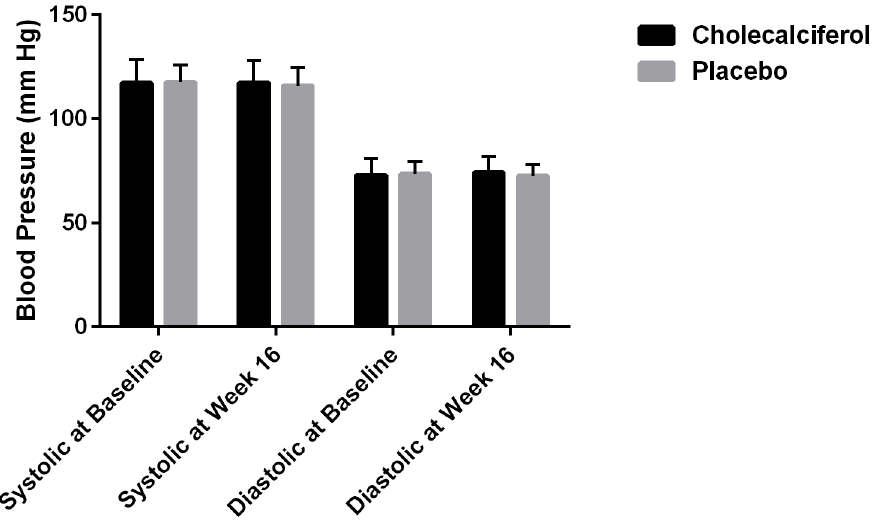
Fig 5. Treatment Effect on 24-hour Ambulatory Blood Pressure.